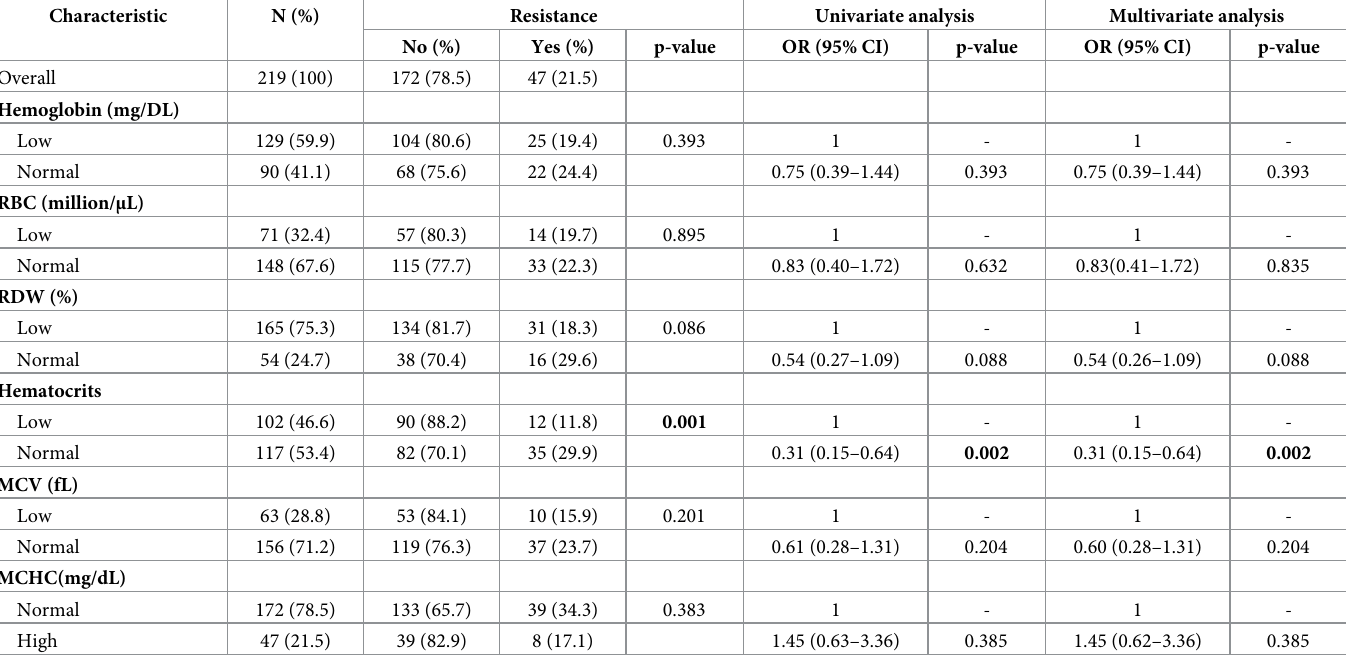
Table 2. Erytrogram and antimalaric resistance among patients with malaria in Luanda, Angola.